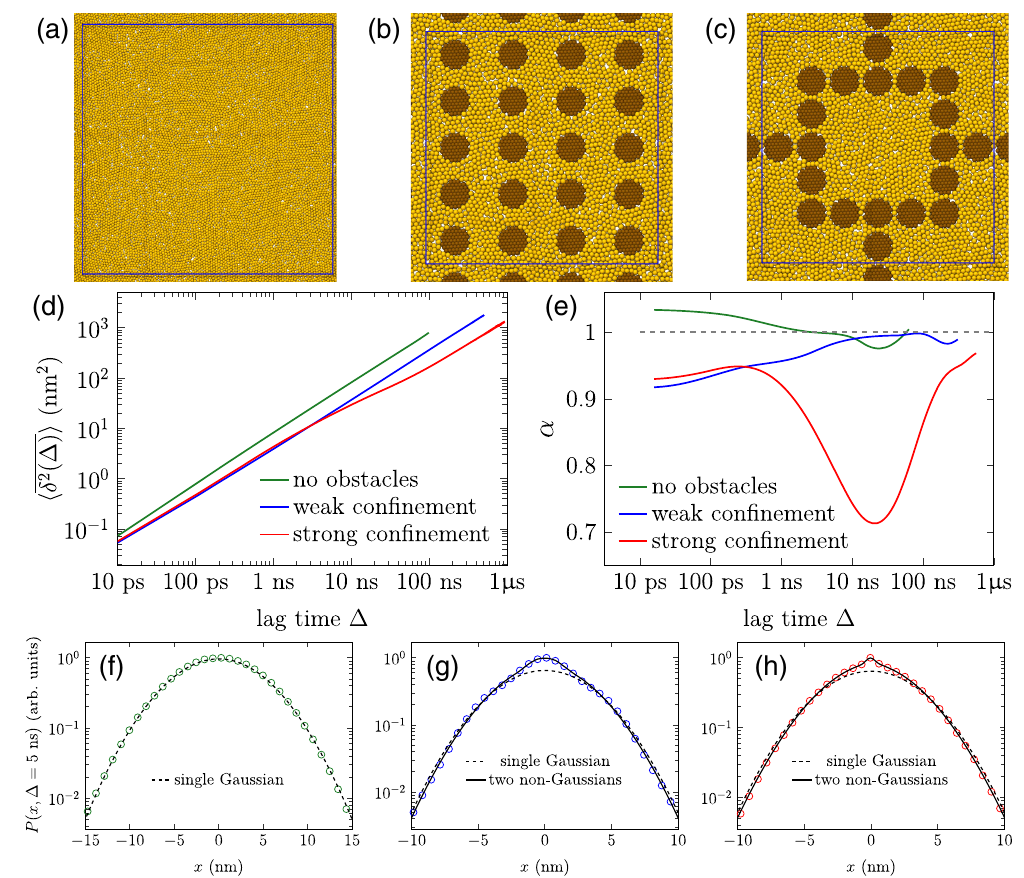
FIG. 10. (a) – (c) The Lennard-Jones (LJ) argon fluid systems simulated in our study. (a) The 2D argon fluid without obstacles. (b) The argon fluid particles with an obstacle arrangement that leads to weak confinement. (c) The argon fluid with an obstacle arrangement that gives rise to strong confinement. Note that the effect of confinement in (b) and (c) is transient. (d) The averaged time-averaged MSD curves for the argon particles in (a) – (c) systems. (e) The anomalous diffusion exponent α versus lag time Δ estimated from the mean time-averaged MSDs in (d). (f) The x component propagator P ð x; Δ ¼ 1 ns Þ with a single-Gaussian fit (dashed line) for the obstacle- free case. (g) The propagator P for the weakly confined argon particles with a single-Gaussian (dashed line) and double-non-Gaussian (solid line) fits. (h) The propagator P for the strongly confined argons with a single-Gaussian (dashed line) and double-non-Gaussian (solid line)